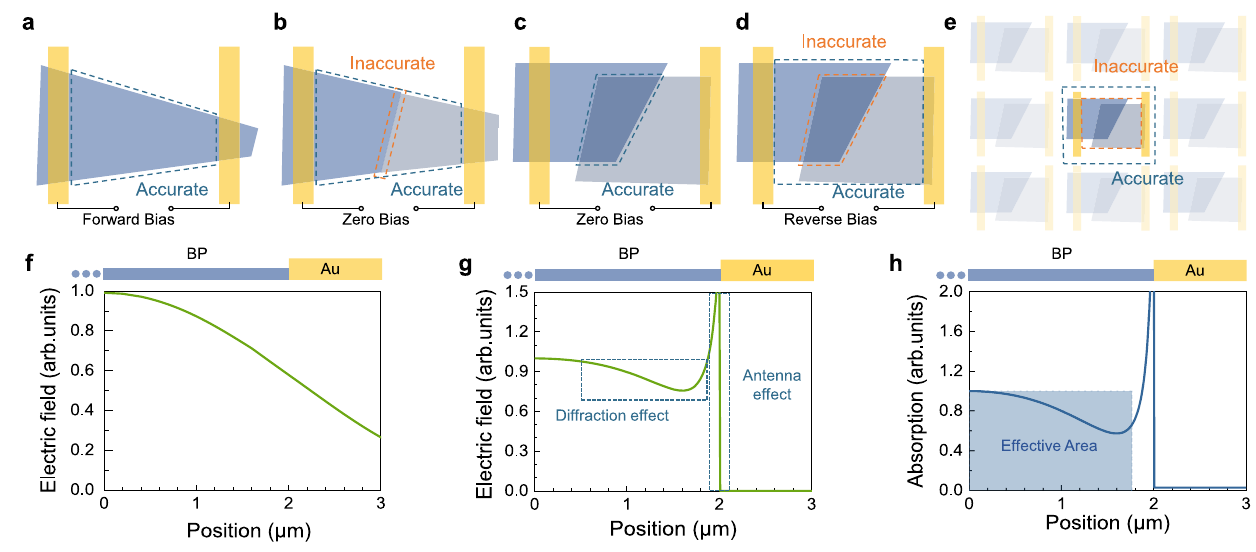
Fig. 1 | Effective area of different types of 2D photodetectors. a Photoconductive photodetector. b Planar junction photodetector. c , d Vertical junction photodetectors with zero and reverse bias, respectively. e Focal plane photodetector.Thedashedbluelinesin a – e aresuggestedaccurateeffectiveareas. The dashed orange lines in b , d , and e are potential inaccurate effective areas for